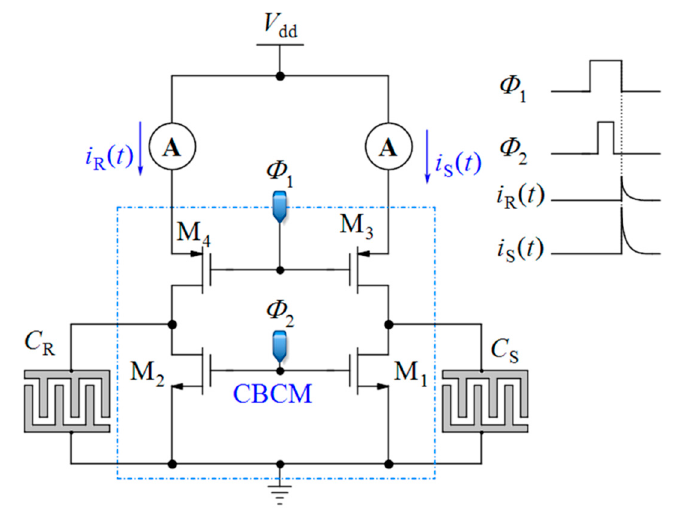
Figure 2. Core of the charge-based capacitance measurement (CBCM).